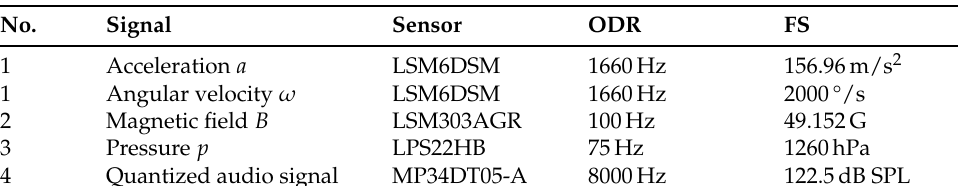
Table 2. Sensor properties as set on the development kit. Recording sensor, output data rate (ODR) and full scale (FS) are assigned to the respective signal. For more information, we refer the reader to the relevant datasheets [23–29].